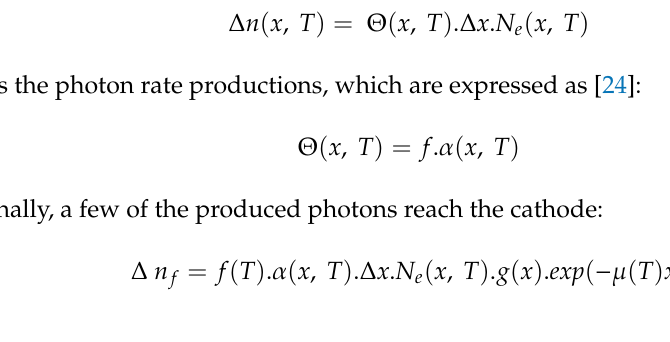
Figure 5. Flowchart of the calculation of the corona-onset voltage of WDESP.